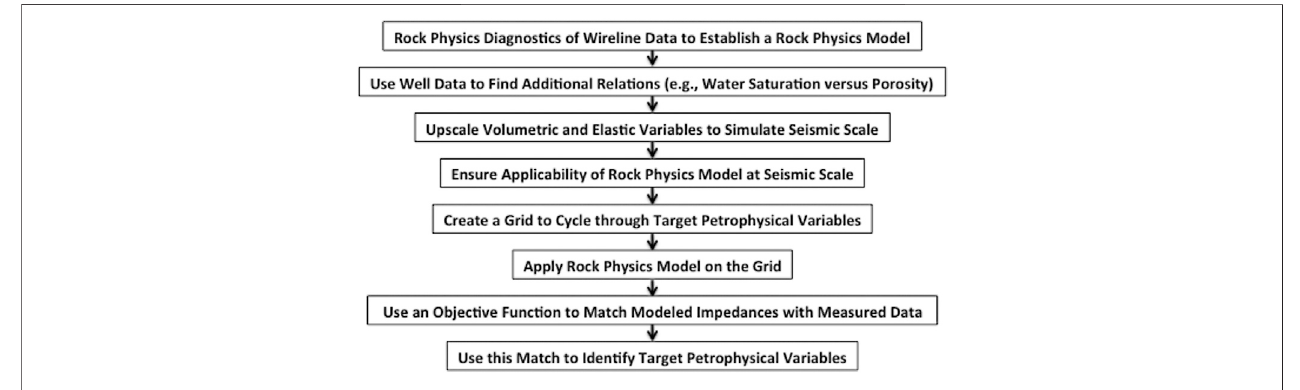
FIGURE A1 | Interpretation